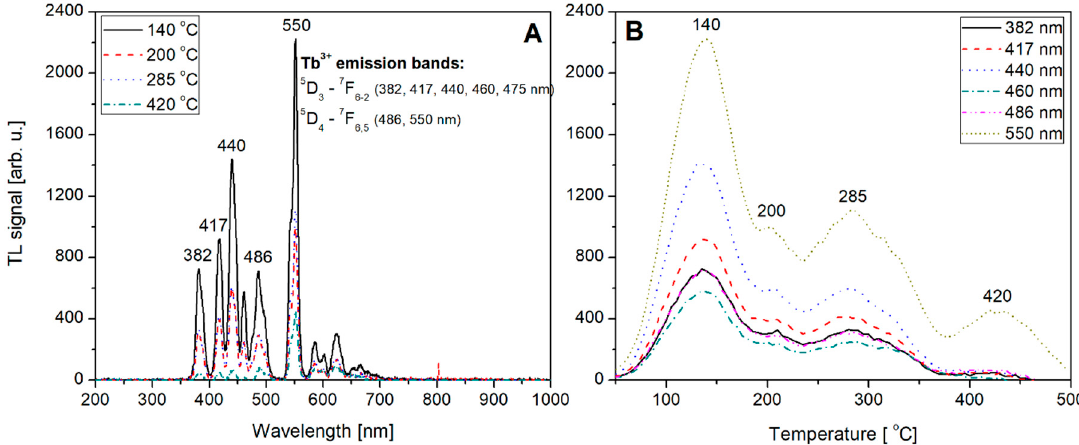
Figure 10. TL emission spectra (panel A ) measured for Tb-doped (0.8) LiMgPO 4 crystal at different temperatures corresponding to the glow-peaks maxima. TL glow-curves (panel B ) measured for the same Tb-doped LiMgPO 4 crystal (irradiated with beta radiation) at different wavelengths corresponding to emission maxima.